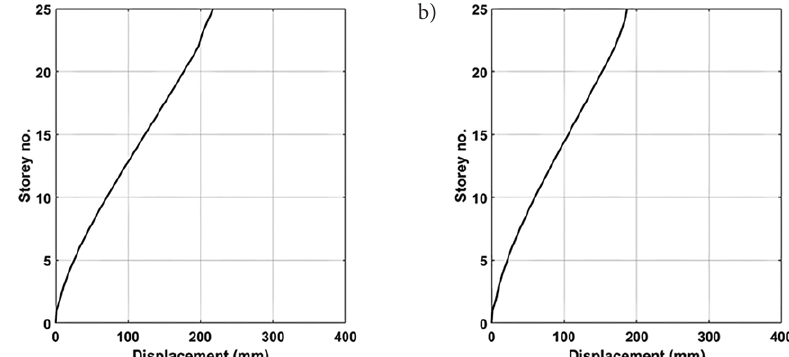
Figure 10. Peak story displacement curves vs. story number under RS analysis in the: a – transverse direction and b –